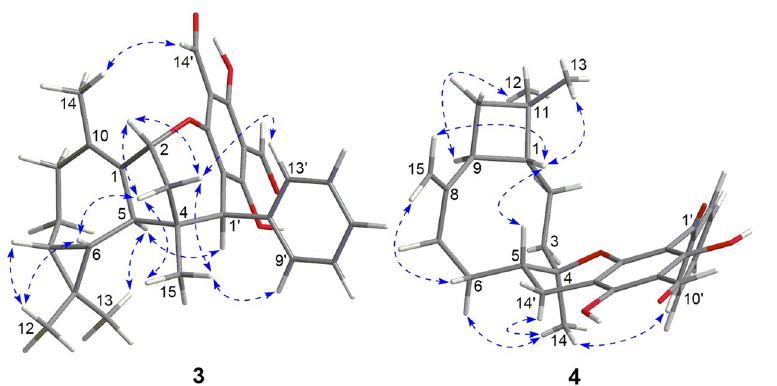
Figure 7. Selected NOESY correlations of 3 and 4 .